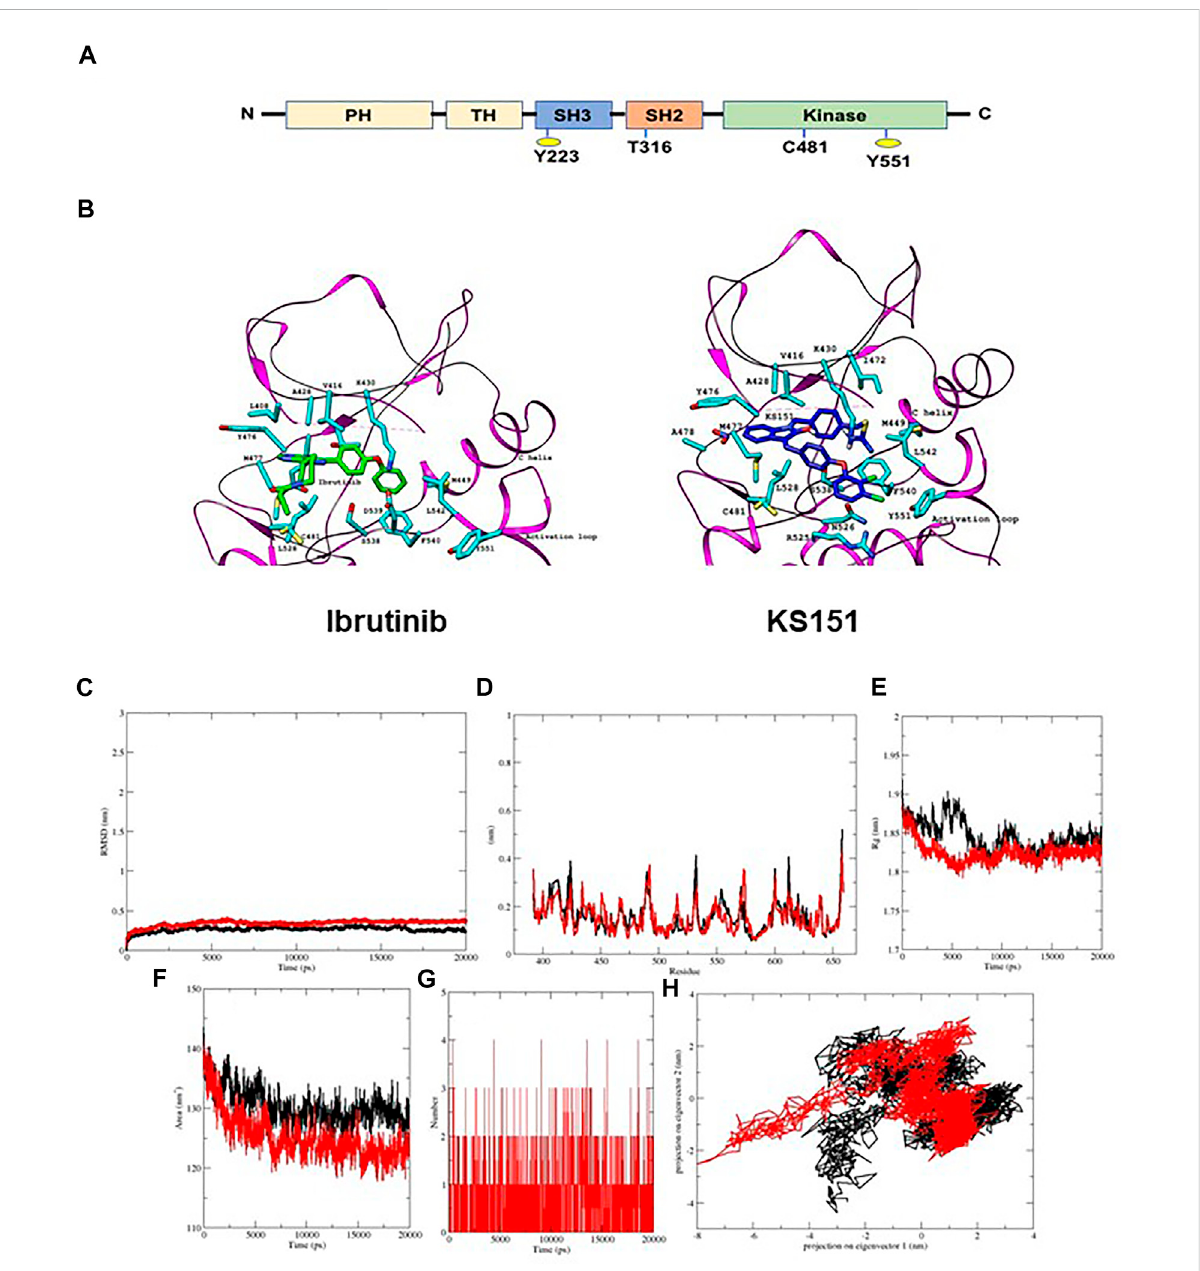
FIGURE 1 KS151 interacts with the BTK. (A) structural domain of BTK. BTK contains fi ve domains, which includes the amino terminal pleckstrin homology (PH) domain, a proline-rich TH domain, SRC homology (SH) domains SH2 and SH3, as well as the kinase domain. (B) the interaction of ibrutinib and KS151 to the activation loop of BTK. On the left, the crystal structure of BTK bound to Ibrutinib and on the right the crystal structure of BTK protein bound with KS151. (C-H) conformational stability of hBTK (black) and hBTK-KS151 complex(red)during 20ns molecular dockingsimulation (C), BackboneRMSDdifferencesofhBTK-apoandhBTK-KS151complex (D) RMSFdifferenceshBTK-apoandhBTK-KS151complex (E) Radiusofgyration differences between hBTK-Apo and hBTK-KS151 complex (F) Average number of H-bonds as a function of time in hBTK-Apo and hBTK-KS151 complex(red) (G) AccessiblesurfaceareainhBTK-Apo andhBTK-KS151 complex (H) ProjectionofC α atomsinessential subspace alongthe fi rsttwo eigenvectors of hBTK (black) and hBTK-KS151 complex (red) showed different projection